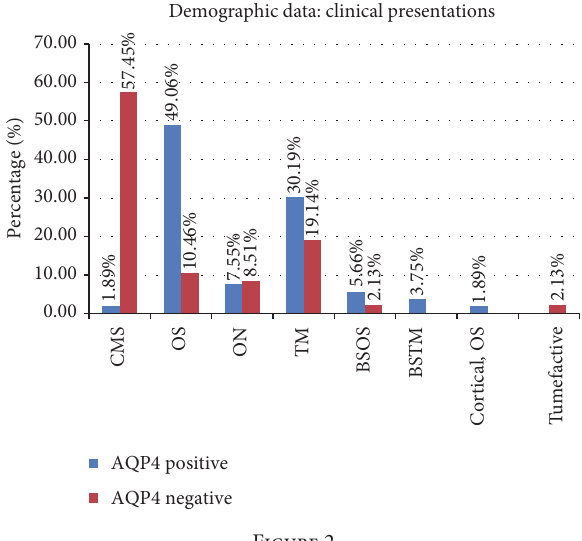
(OCB) Status. Data on CSF OCB was only available in 12/53 patients in the AQP4-positive group and 30/47 patients in the seronegative group. CSF OCB was detected in 7/12 (58.33%) patients in the seropositive group and 17/30 (56.67%) patients in the seronegative group (Table 2). Nevertheless, 13 patients were negative for both AQP4 and CSF OCB. 3.4. Spinal Cord Lesion on the MRI. The MRI of the spinal cord was available in 40/53 AQP4-positive patients and in 30/43 AQP4-negative patients. In total, 29/40 (72.50%) in the seropositive group had longitudinally extensive spinal cord lesions (LESCLs) on MRI as compared to 7/37 (18.92%) in the seronegative group, with a 𝑝 value of 0.004. In contrast,